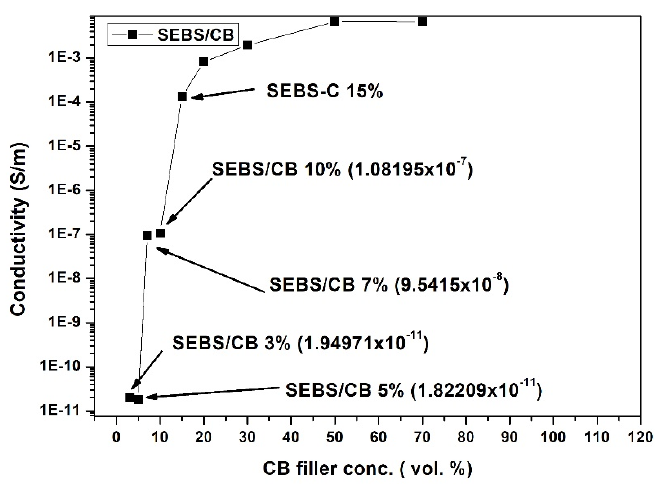
Figure 2. Percolation curve of SEBS/CB vs. conductivity. The arrow refers to chosen composite concentration for whole experimental study.